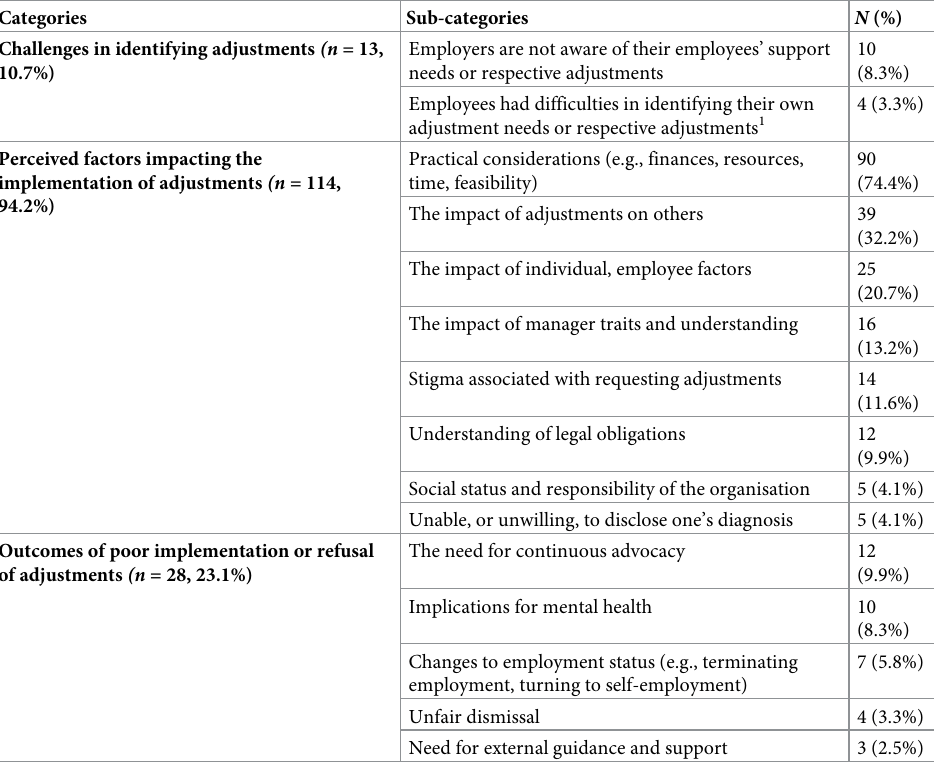
Table 5. Factors related to the experience of workplace adjustments ( n =